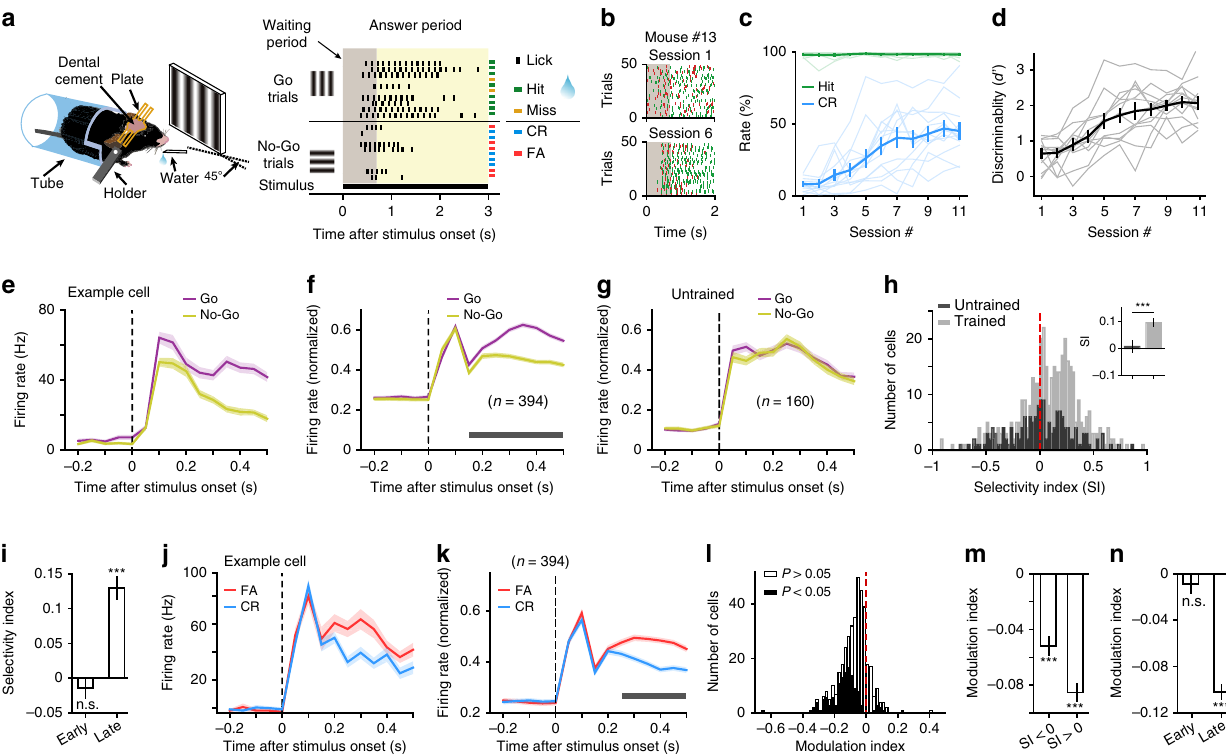
Fig. 3 Responses of V1 neurons in Go/No – Go visual task. a Behavioral setup and task structure. b Example lick rasters in two sessions c Hit rate (green), F = 0.43, P = 0.71; CR rate (blue), F = 23.57, P = 2.1 × 10 − 9 . d Discriminability, F = 33.34, P = 1.1 × 10 − 14 . Each thin line (2.72,32.62) (3.36,40.28) (4.49,53.86) represents a mouse. One-way repeated measures ANOVA with the Greenhouse-Geisser correction for c and d . e Responses of an example neuron to Go and No – Go stimuli. f Normalized responses of V1 neurons in Go and No – Go trials. Horizontal bar, timepoints with P < 0.05, two-way repeated measures ANOVA F (1,393) = 55.7, P = 5.5 × 10 − 13 followed by Sidak ’ s multiple comparisons test. g Responses of V1 neurons from untrained mice ( P = 0.56, two-way repeated measures ANOVA F (1,159) = 0.33). h Distribution of SIs. Light gray, trained mice, P = 2.2 × 10 − 12 , n = 394 neurons. Dark gray, untrained mice, P = 0.62, n = 160 neurons. Wilcoxon two-sided signed rank test. Inset, SIs from untrained and trained mice. *** P = 4.6 × 10 − 4 , Wilcoxon two-sided rank sum test. i SIs for early ( P = 0.51) and late (*** P = 2.1 × 10 − 16 ) response components. n = 394, Wilcoxon two-sided signed rank test. j Responses of an example neuron to No – Go stimulus in FA and CR trials. k Normalized responses of V1 neuron to No – Go stimulus in FA and CR trials. Horizontal bar, timepoints with P < 0.05, two-way repeated measures ANOVA F = 222.22, P < 1 × 10 − 15 followed by Sidak ’ s multiple comparisons test. l Distribution of MIs ( P (1,393)